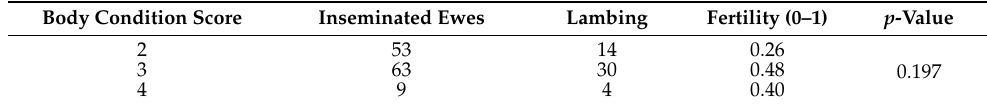
Table 5. Body condition and fertility in organic Churra ewes in Spain. Body Condition Score